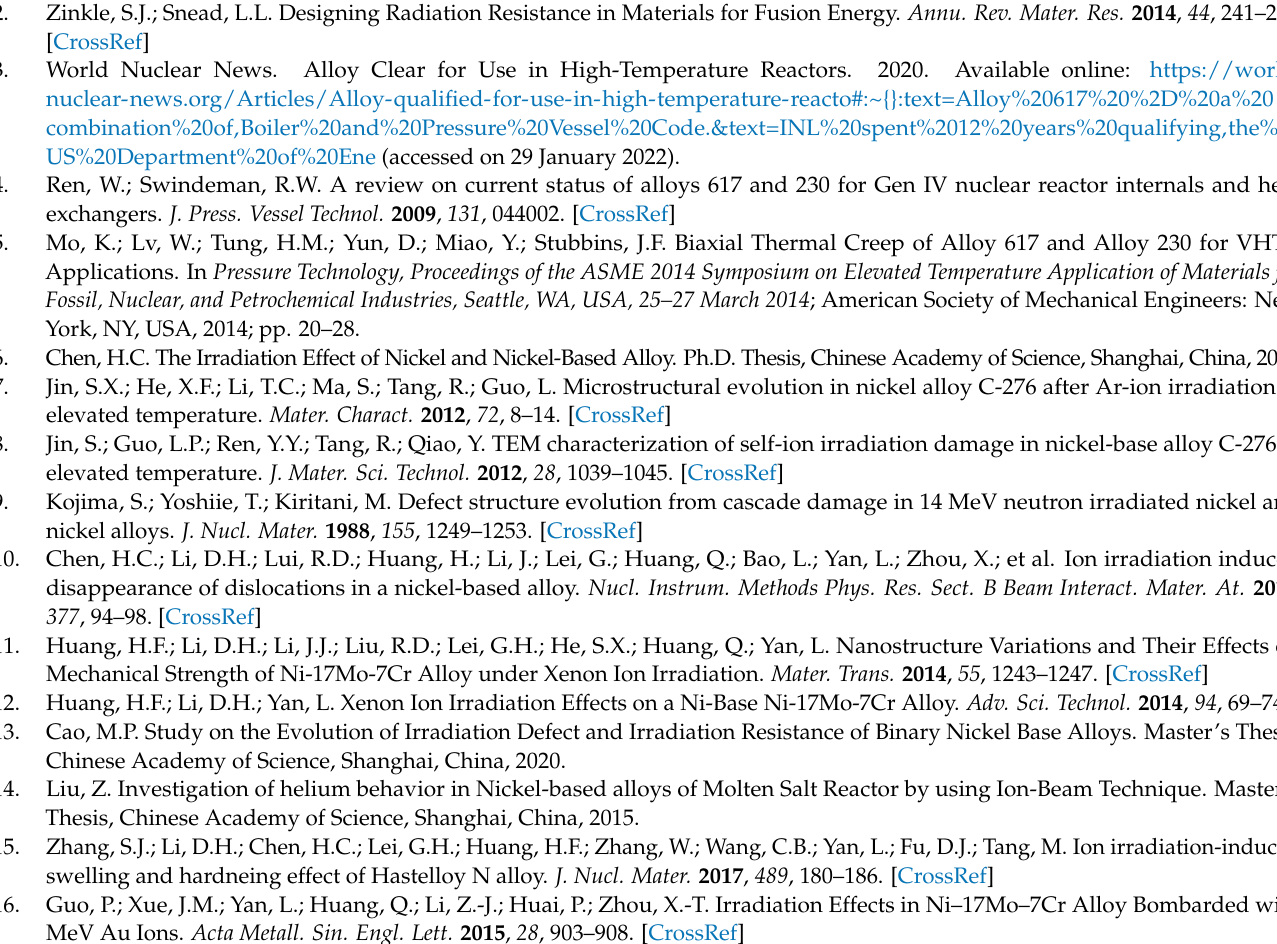
punch test; Figure S2: The load–deflection curves of the samples after annealing at 800 ◦ C for 2 h; Figure S3: (a,b) Overall morphology, (c–e) the cracks on the implanted surface of unirradiated samples under different annealing conditions; Table S1: The tensile characteristic value and fracture characteristic value of unirradiated samples after different annealing